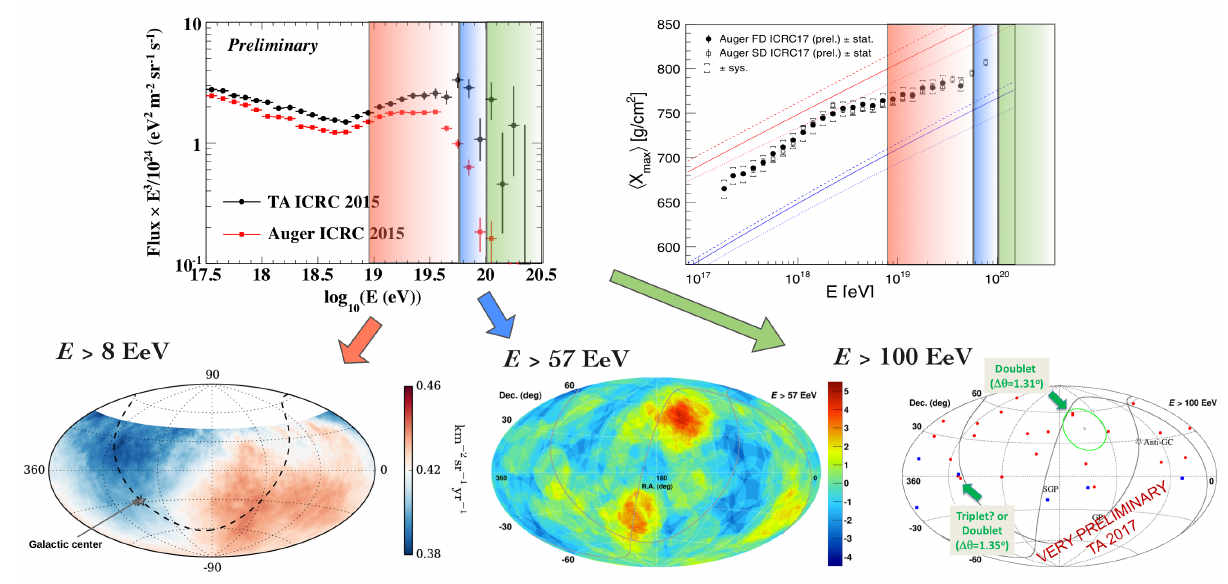
Figure 2. Overview of three important observables reported by the Pierre Auger Observatory and Telescope Array Experiment: energy spectrum [6–8] mass composition [9–11] and arrival direction [12–15] with energy ranges indicated above: 8 EeV (red), 57 EeV (blue) and 100 EeV